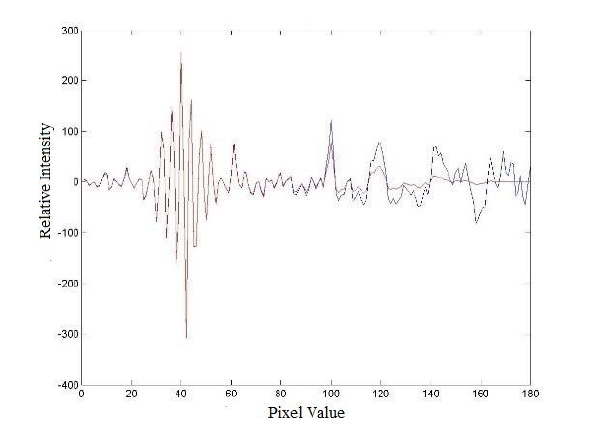
Figure 7. Comparison of results before and after apodization